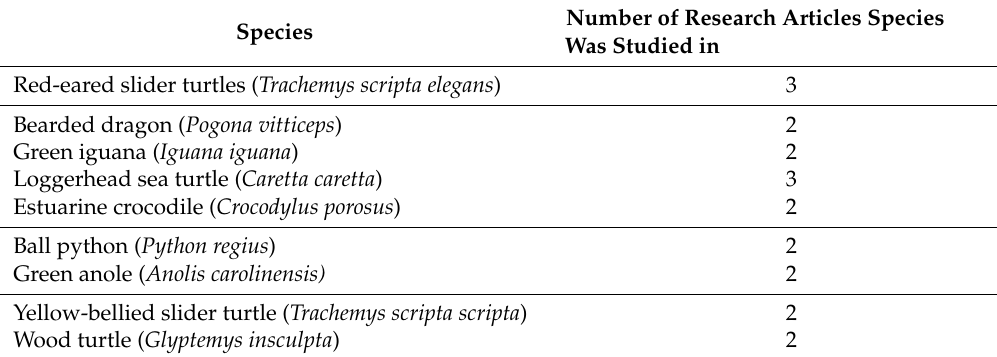
Table 4. Species that were studied in more than one article.